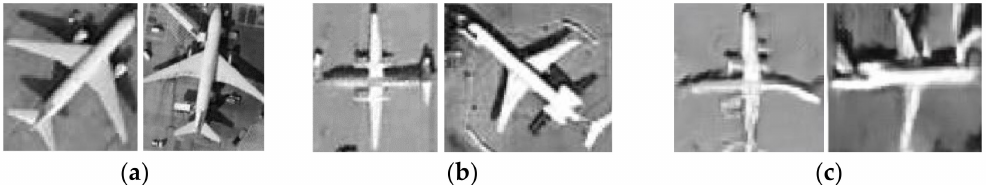
Figure 6. Different types of aircraft and their generated pictures. ( a ) Civil aircraft; ( b ) other kinds of aircraft; ( c ) their generated images. There is a big difference in shape between civil aircraft and other types of aircraft, which contributes to the unclassified generated